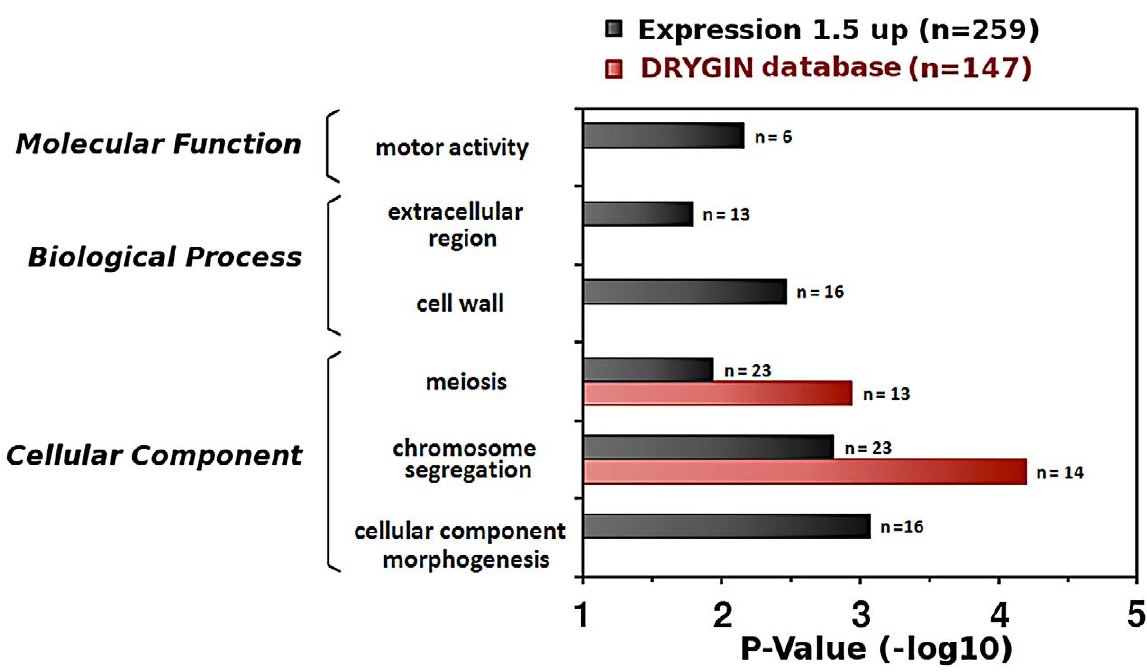
Figure 2. Gene expression profile and genetic interactions indicate roles for Fun30 in meiosis and chromosome segregation. Merged histogram of Gene Ontology analysis for 1.5-fold up-regulated mRNAs (n=259 genes with annotated function in GO) in D fun30 cells compared to wildtype cells and for genes interacting synthetically with FUN30 from the DRYGIN database (n=147, Epsilon cutoff 0.04 and P-value cutoff 0.05) [37]. Identified gene categories are indicated. Abscises show the P value ( 2 log 10). The gene list is in supplementary data.